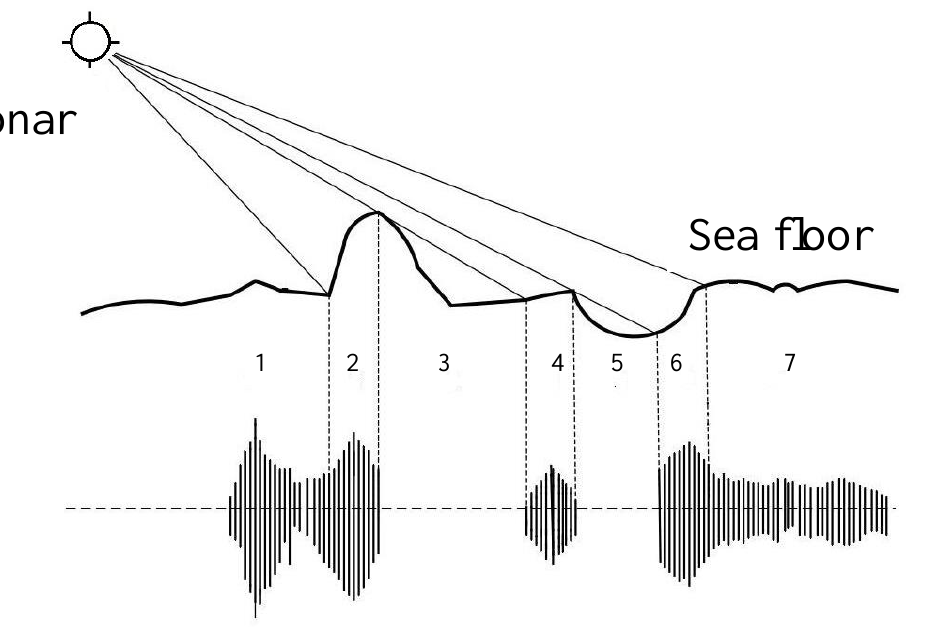
Figure 1. Echo intensity of side scan